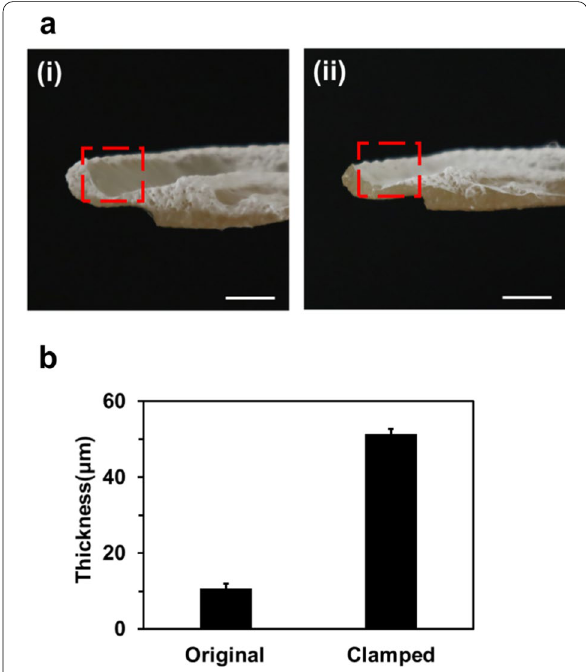
Fig. 5 a Electrospun nanofiber mats on the scapha of the original hydrogel collector ( a -(i)) and the flattened hydrogel collector ( a -(ii)). b The thicknesses of the electrospun nanofiber mats at the scapha on the original and the flattened hydrogel collector. All scale bars are 1